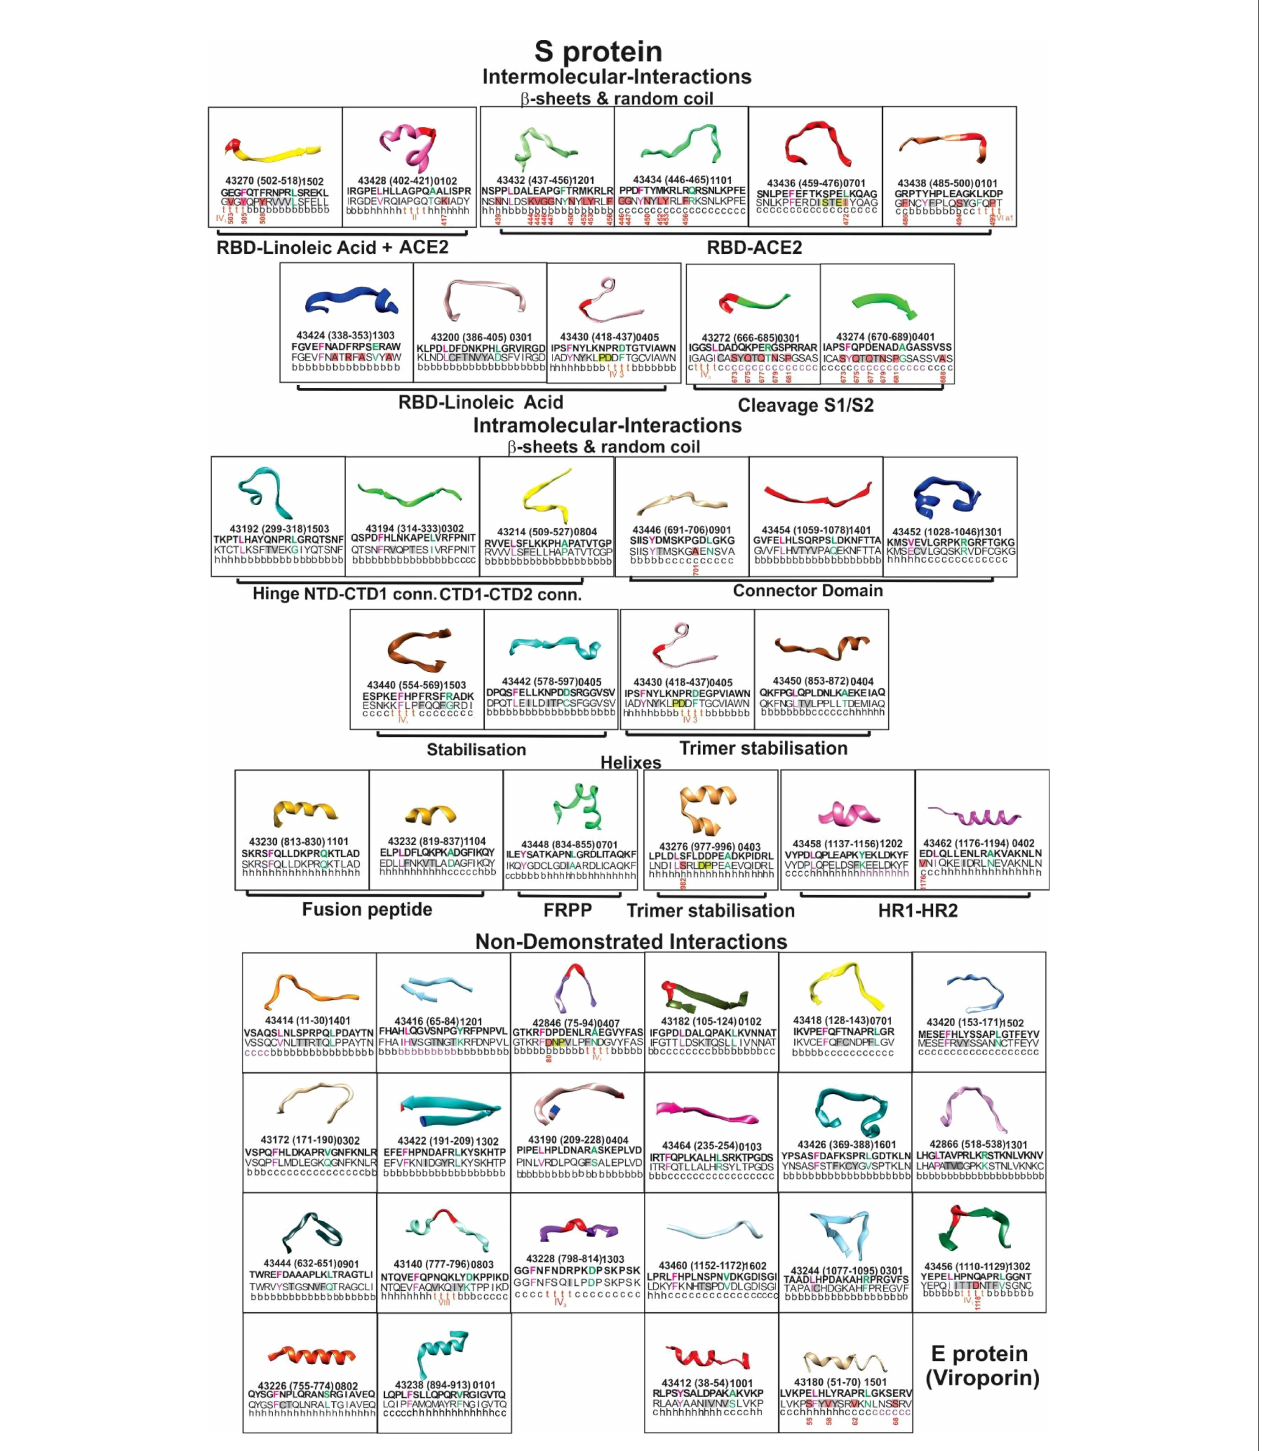
FIGURE 3 | Selected peptides ’ structure. The boxes show ribbon representations of selected S (PDB code: 6X6P, 6VXX, and 6VYB) and E (PDB code: 5X29) peptides, according to their 3D structure, classi fi ed as b -sheet, random coil, a -helixes (on top), and functional activities (bottom in bold letters). Inside, the Institute ’ s peptide numbers, their location in the aa sequence (in parenthesis) and HLA-DR b 1* allele they bind to. Modi fi ed peptides ’ aa sequences above in bold letters; native peptides ’ aa sequences below, with secondary structure. Red bold and green letters show residues fi tting into HLA-DR b 1* P1 to P9. Red shading shows aa having a high mutation rate with position number in the aa sequence; grey shading shows aa having low PPII L propensity (Aro, b -branched aa). Their functional activities are shown in bold letters outside the